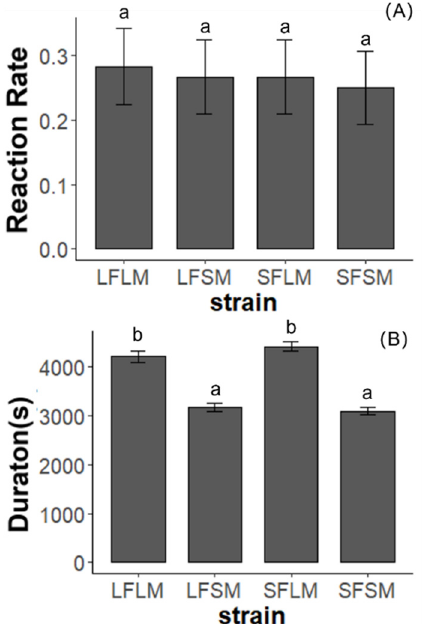
Figure 6. The copulation performance of the SPW for LF × LM, LF × SM, SF × LM, and SF × SM treatments. ( A ) The response of virgin males to females in four treatments. ( B ) The duration of copulation in four treatments. Treatments with different letters are significantly different ( p < 0.05). Error Standard errors are shown on the column